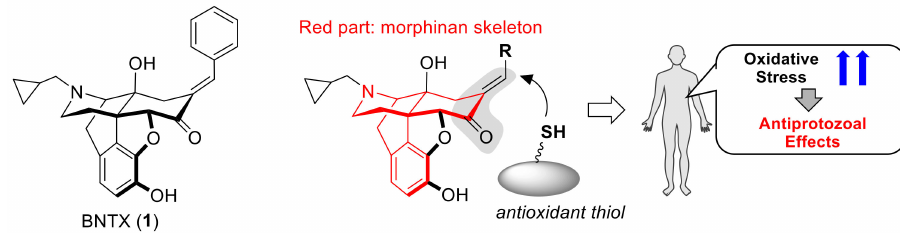
Figure 1. StructureofBNTX( 1